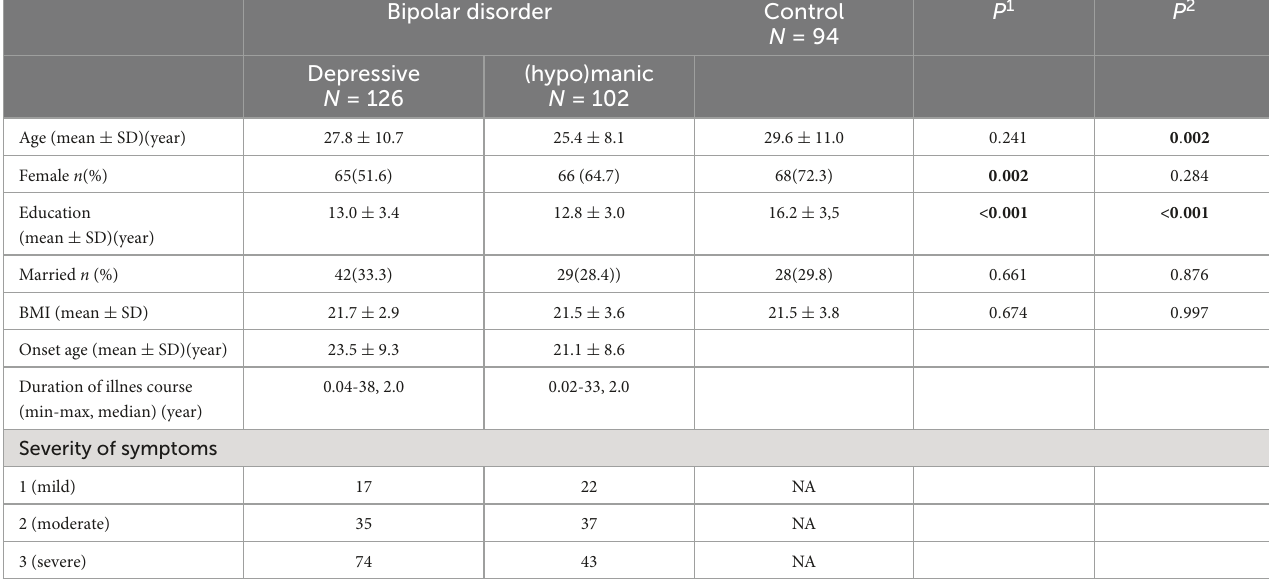
TABLE 2 Demographic and clinical characteristics of all the